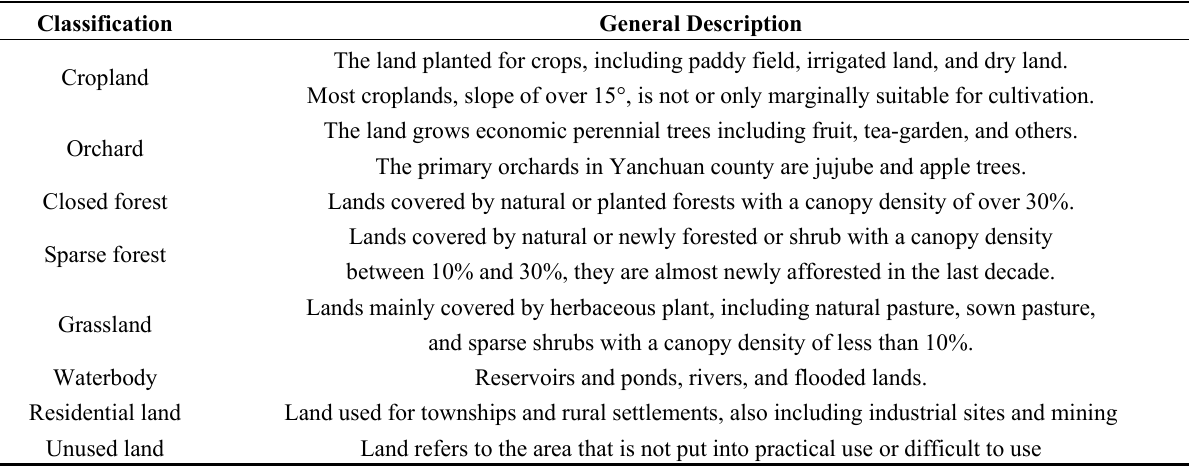
Table 2. Land use/cover classification in Yanchuan